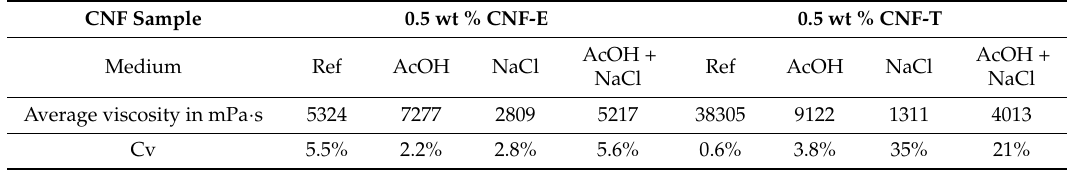
Table 3. Apparent viscosity of CNF-stabilized emulsions in mPa · s (average value and coefficient of variance (Cv) based on two replicates). The media are the following. Ref: deionized water; AcOH: 0.2